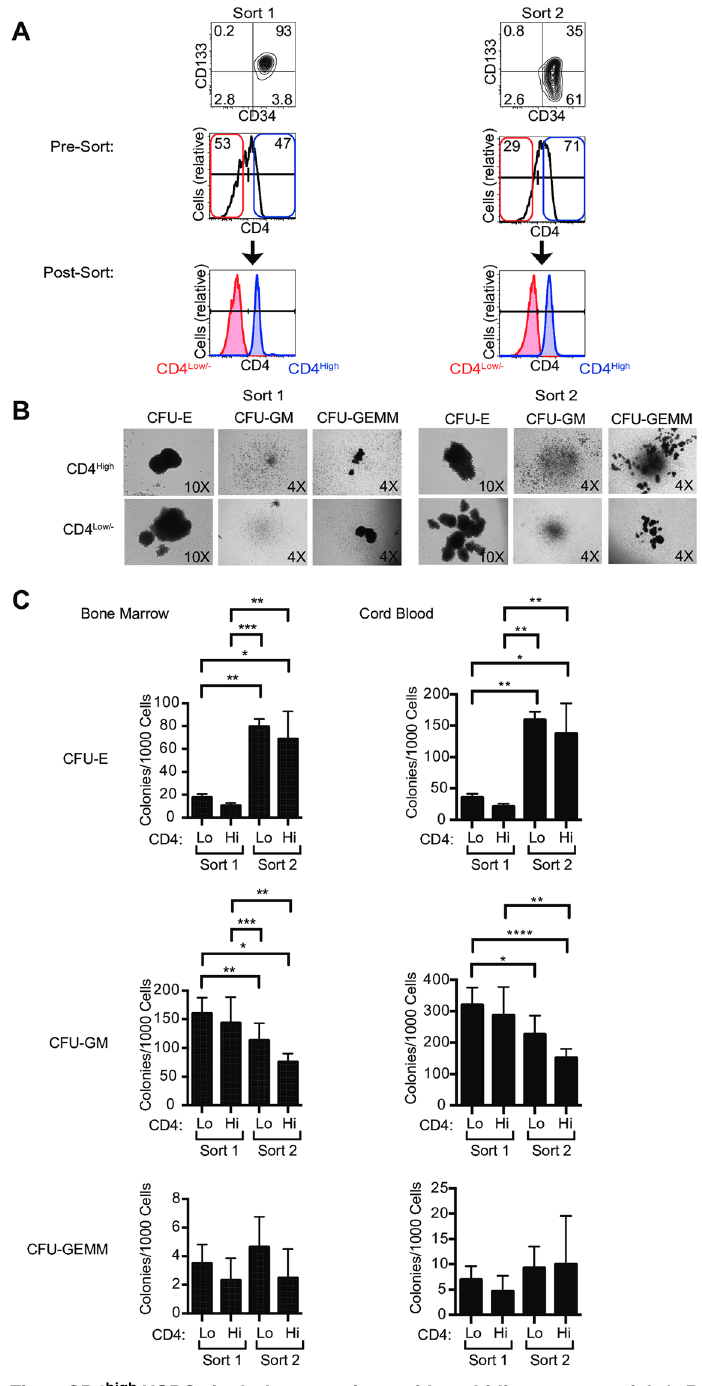
Fig 7. CD4 high HSPCs include progenitors with multi-lineage potential. A. Representative flow plots of Sort 1 and Sort 2 bone marrow-derived HSPCs sorted using fluorescence activated cell sorting into CD4 high and CD4 low/- subsets. B and C. Sorted HSPCs were analyzedby methylcellulose colony formation assays. Mean ± standarddeviationis indicatedfor counts from three blindedinvestigators; 2-tailedStudent’st-test ( * p < 0.05, ** p < 0.01, *** p < 0.001, **** p < 0.0001). CFU-E, erythroid; CFU-GM, granulocyte/macrophage and CFU-GEMM, multilineage.